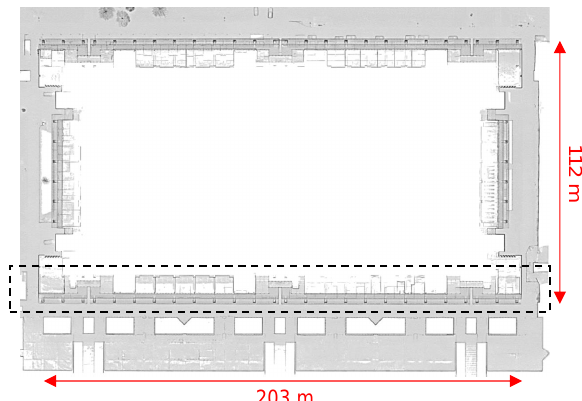
Figure 2. X-ray orthophoto of the University building (2.5D orthophoto generated from the HERON Lite point cloud projected on the horizontal plane). The dashed line rectangle indicates the south facade, on which the subsequent analyses focused.